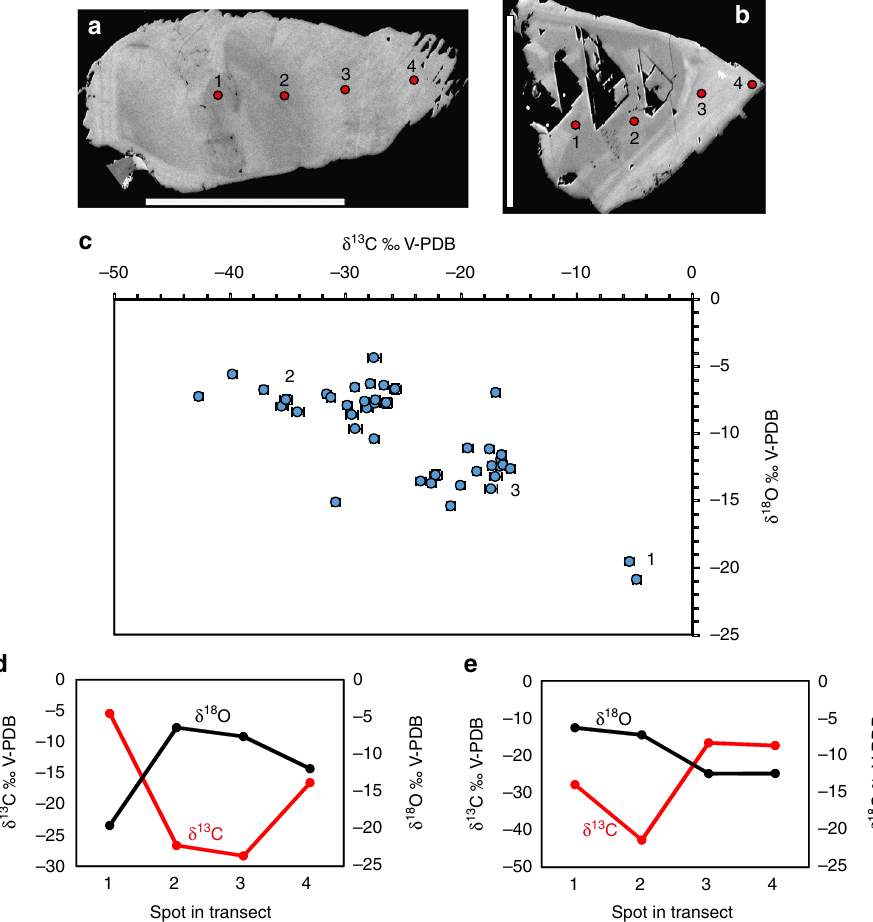
Fig. 7 Stable isotope composition of calcite determined by Secondary Ion Mass Spectrometry (SIMS). ( a , b ) Examples of polished cross-sections of calcite crystals in high contrast back-scattered Environmental Scanning Electron Microscopy (ESEM)-images. Several different growth generations are visible (discerned by their back-scatter intensity, growth direction from left to right). Weathering is seen in the outermost (right) part of the crystal in b . Circles represent SIMS-spots (1 – 4). ( c ) All isotopic results (error bars, 1 SD, within size of symbols if not visible), including three different generations denoted according to relative age as seen in the polished cross-sections. ( d , e ) Transects in crystals shown in a and b , respectively. Error bars are within the size of the symbols. Scale bars are 500 µ m ( b ) and 300 µ m ( c